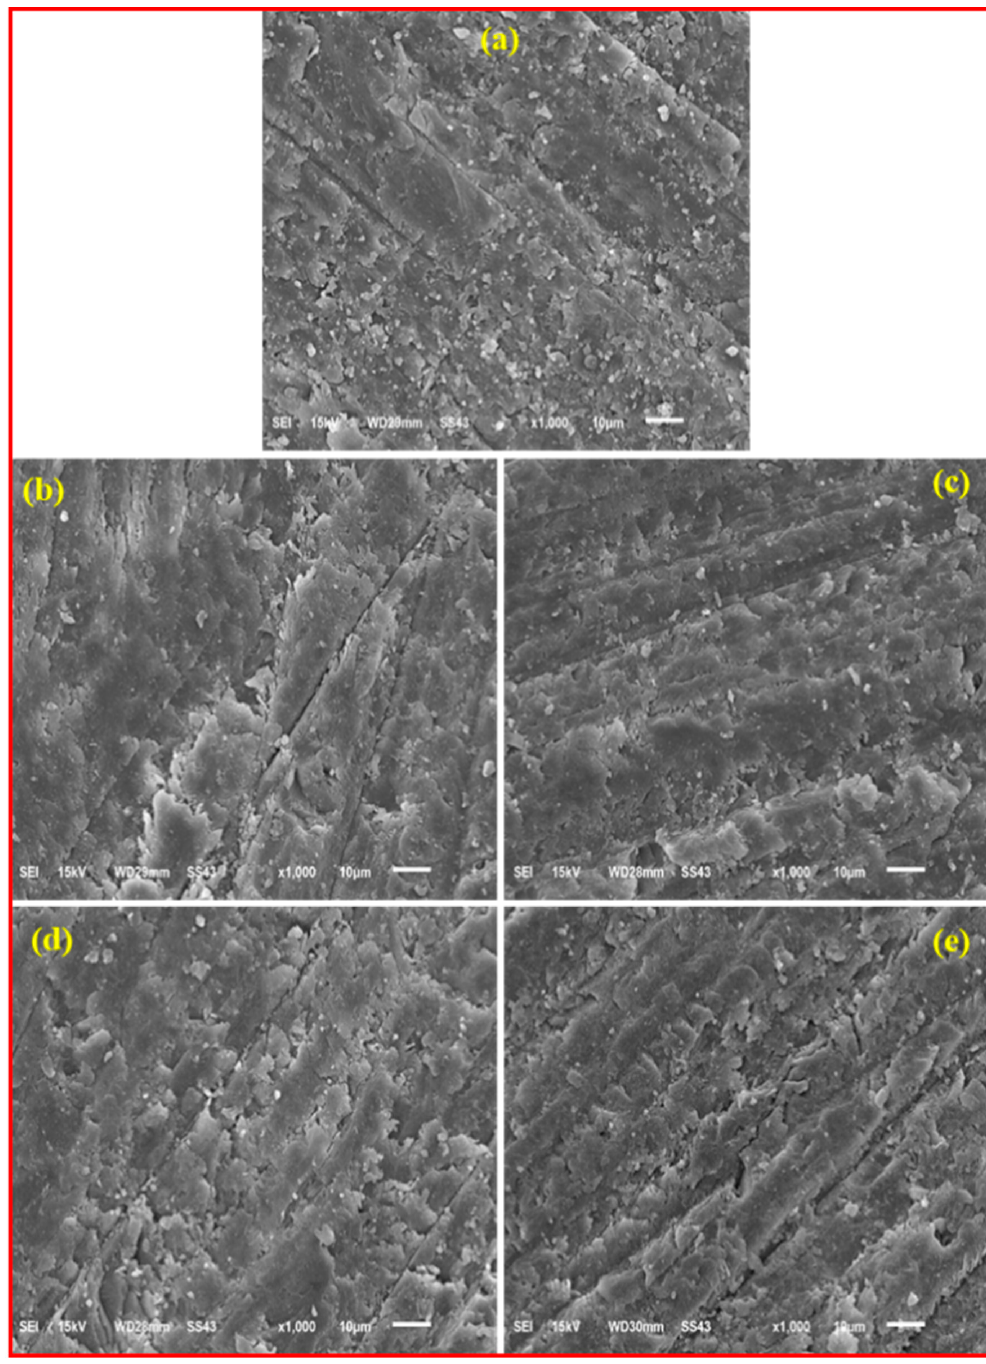
Figure 8. Scanning electron microscopy (SEM) images of fractured surface ( a ) Base composite with 30% SiO 2 (C0.0), ( b ) (C0.5), ( c ) (C1.0), ( d ) C2.0, ( e ) C4.0.